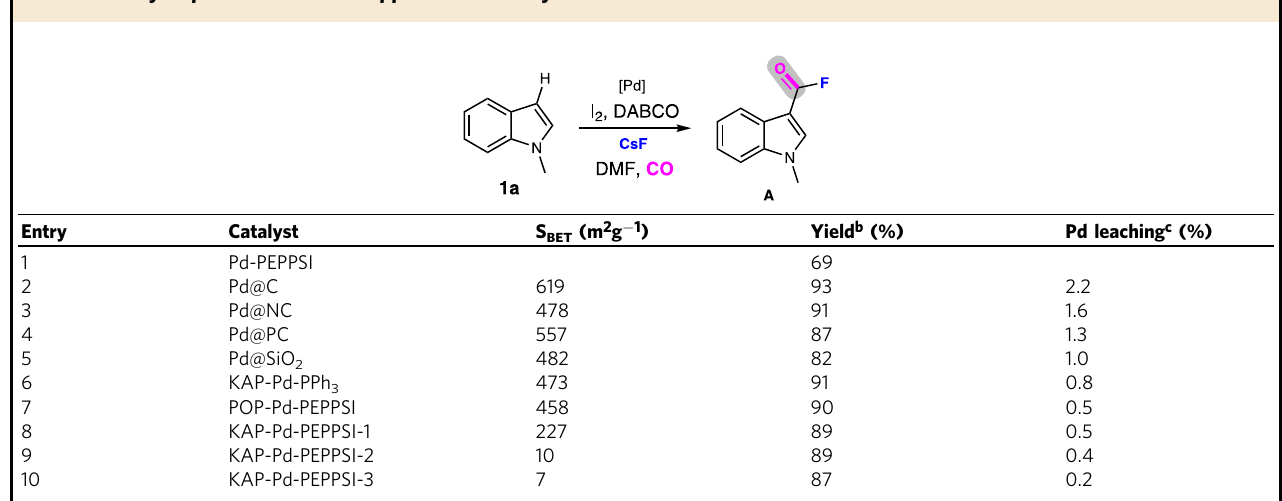
Table 1 Catalytic performances of supported Pd catalysts a